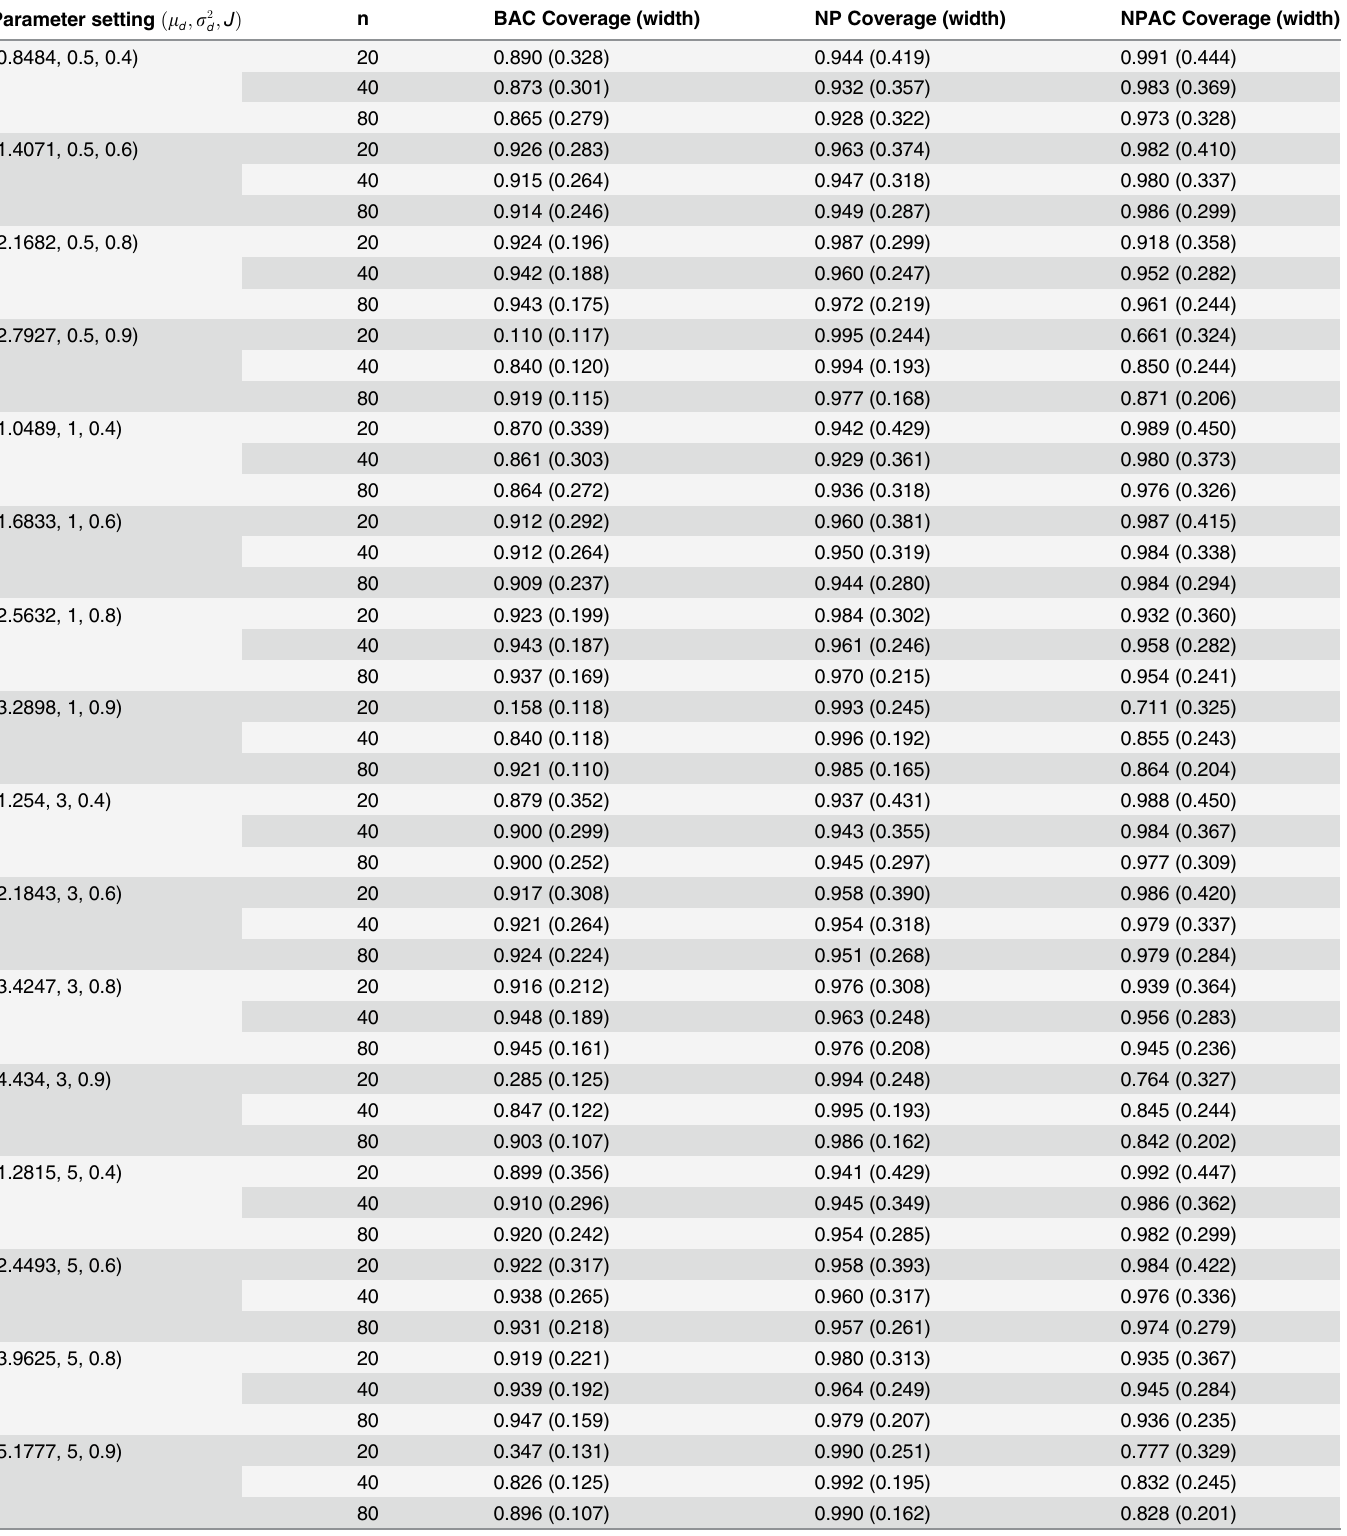
Table 2. Normal distributions: coverage probabilities and average widths when m = 40 in the non-diseased group at the 95% nominal